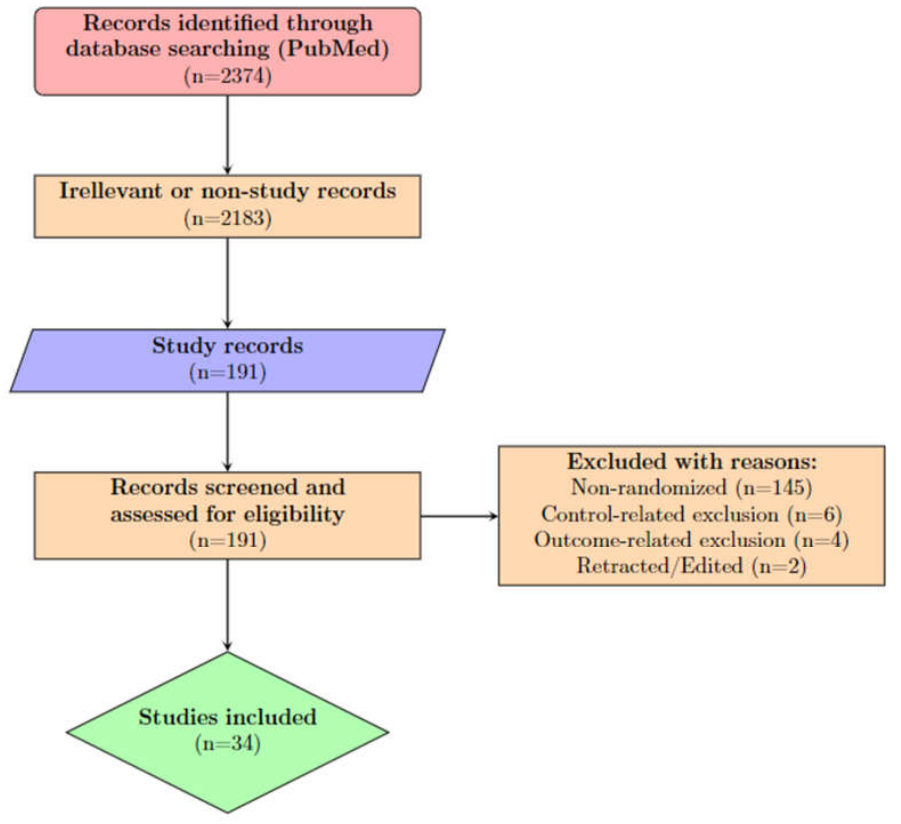
Figure 1. Study selection flowchart. Figure 1 . Study selection flowchart .